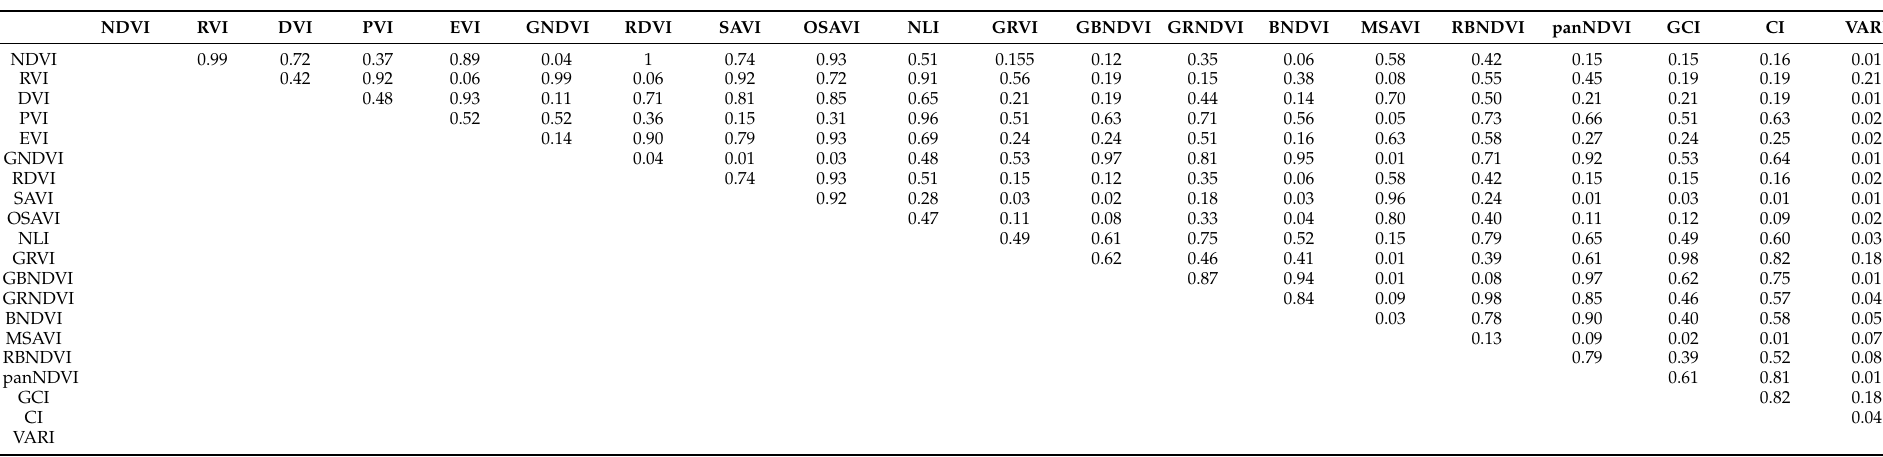
Table A1. Variance Inflation Factor (VIF) of the vegetation index of the input